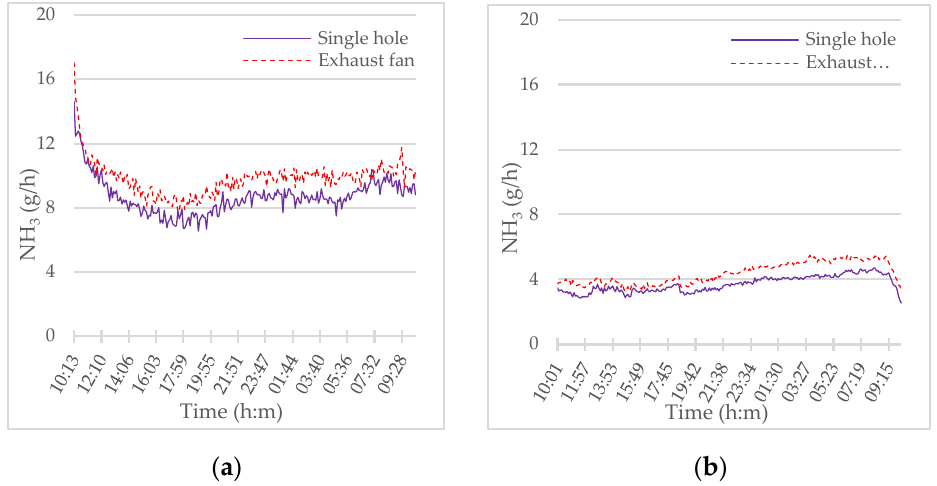
Figure 4. The ammonia (NH 3 ) reduction effect in non-spray conditions inside the curtain: ( a ) the maximum operating rate of the barn exhaust fan (100%), ( b ) minimum operating rate of barn exhaust fan